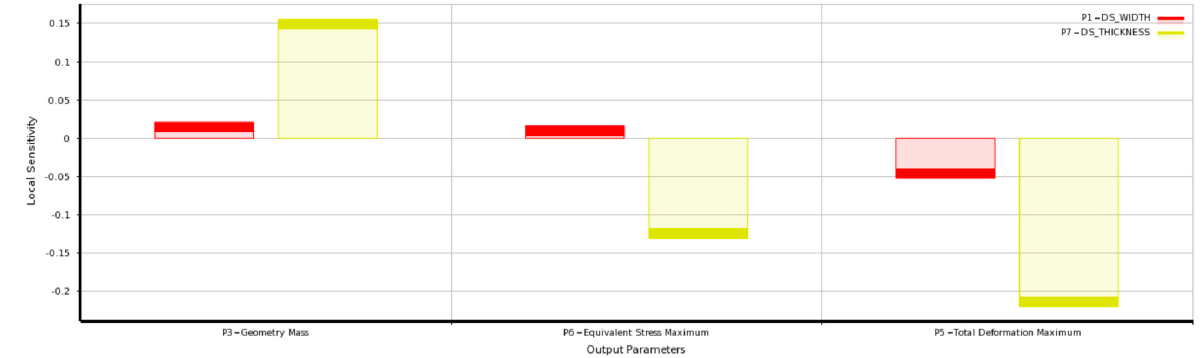
Figure 15. Histogram of local sensitivity of input parameters to output parameters.